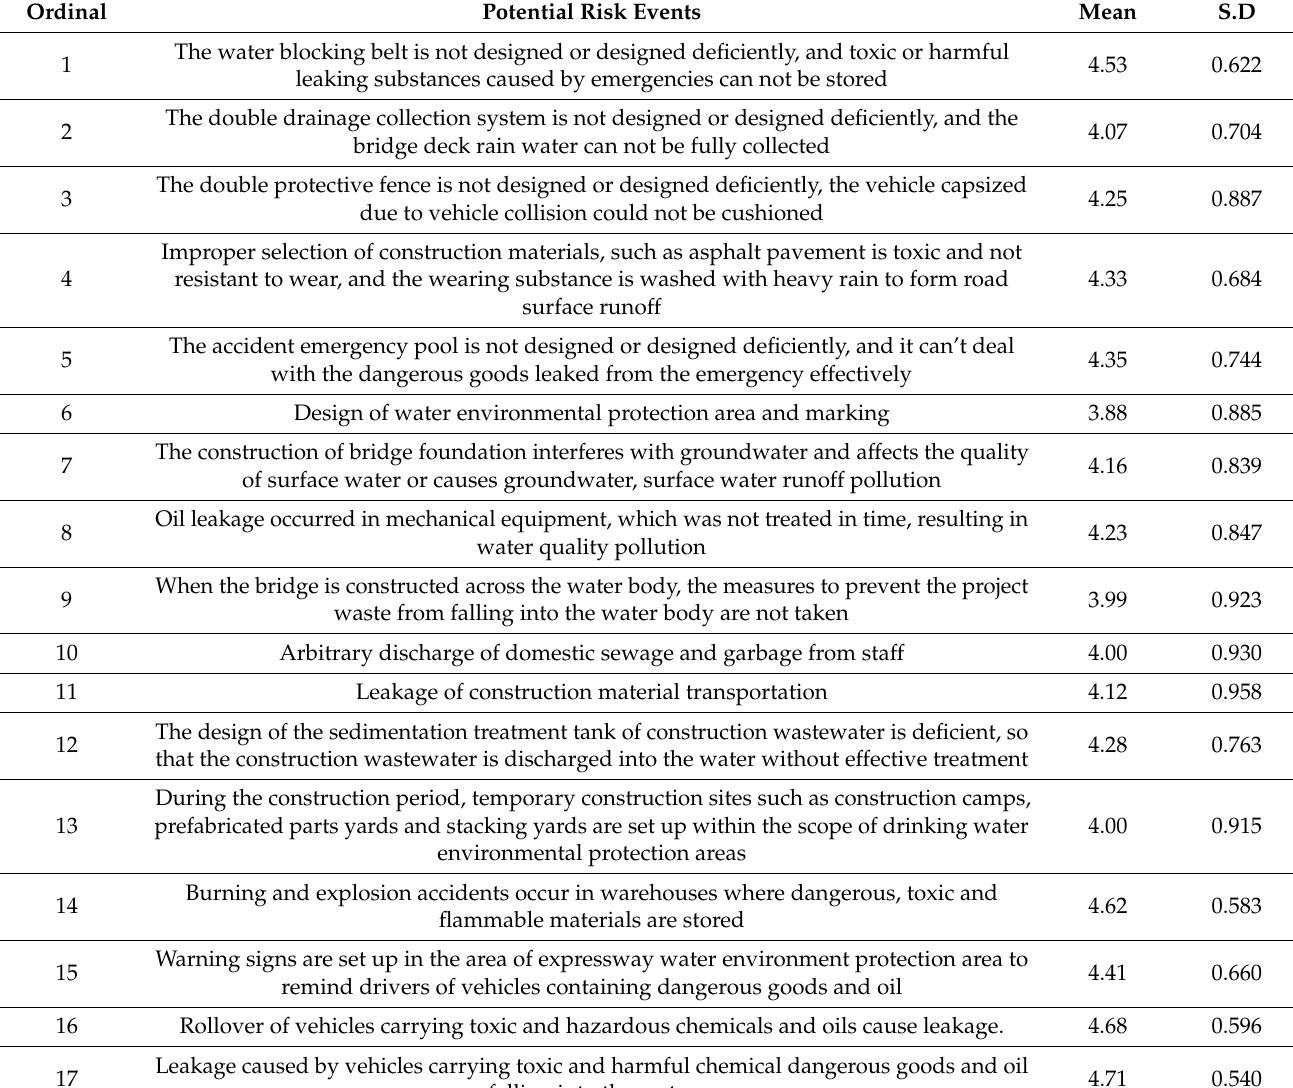
Table 1. Questionnaire results